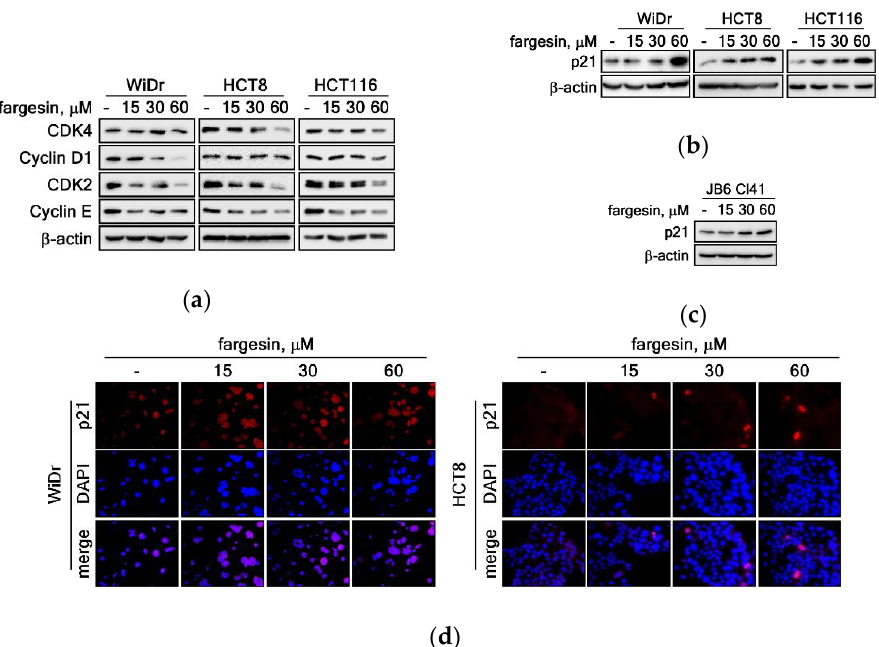
Figure 4. Modulation of CDKs/cyclins-p21 WAF1/Cip1 signaling axis by fargesin induces G 0 /G 1 cell cycle accumulation. ( a ) Fargesin suppresses protein levels of cell cycle regulators involved in G 1 /S cell cycle transition. Total proteins (30 µ g) extracted from the indicated cells were separated by SDS-PAGE, and the indicated proteins were visualized by probing the specific antibodies indicated. β -actin was used to verify equal protein loadings. ( b , c ) Fargesin induces p21 WAF1/Cip1 protein levels in colon cancer cells. Total proteins (30 μg) extracted from WiDr, HCT8, and HCT116 colon cancer cells ( b ) and JB6 Cl41 cells ( c ) were resolved by SDS-PAGE and visualized by probing the p21 WAF1/Cip1 antibody and the HRP-conjugated secondary antibody. β-actin was used to verify equal protein loadings. ( d ) Fargesin induces a p21 WAF1/Cip1 -positive cell population. WiDr (1 × 10 4 cells) and HCT8 (1 × 10 4 cells) colon cancer cells were seeded into 4-chamber slides, cultured for 48 h, and treated with indicated doses of fargesin. The cells were fixed with 4% paraformaldehyde, permeabilized, and hybridized with a p21 WAF1/Cip1 specific antibody and Alexa 568-conjugated secondary antibody. The cells were observed under a fluorescence confocal microscope ( × 200). Representative photographs were obtained from a photograph taken randomly at four different locations/chamber in three independent experiments. Red, p21 WAF1/Cip1 ; blue,